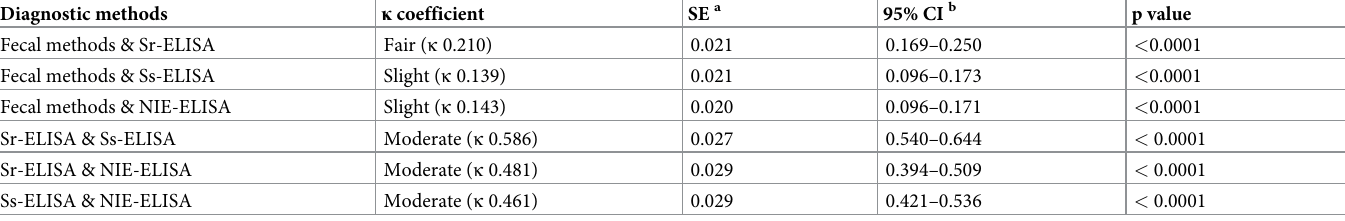
Table 2. Diagnostic agreements between urine ELISA protocols and fecal examination methods and between pairs of different antigen-based ELISA protocols. Data shown are Cohen’s kappa values (based on data from 966 individuals). Diagnostic